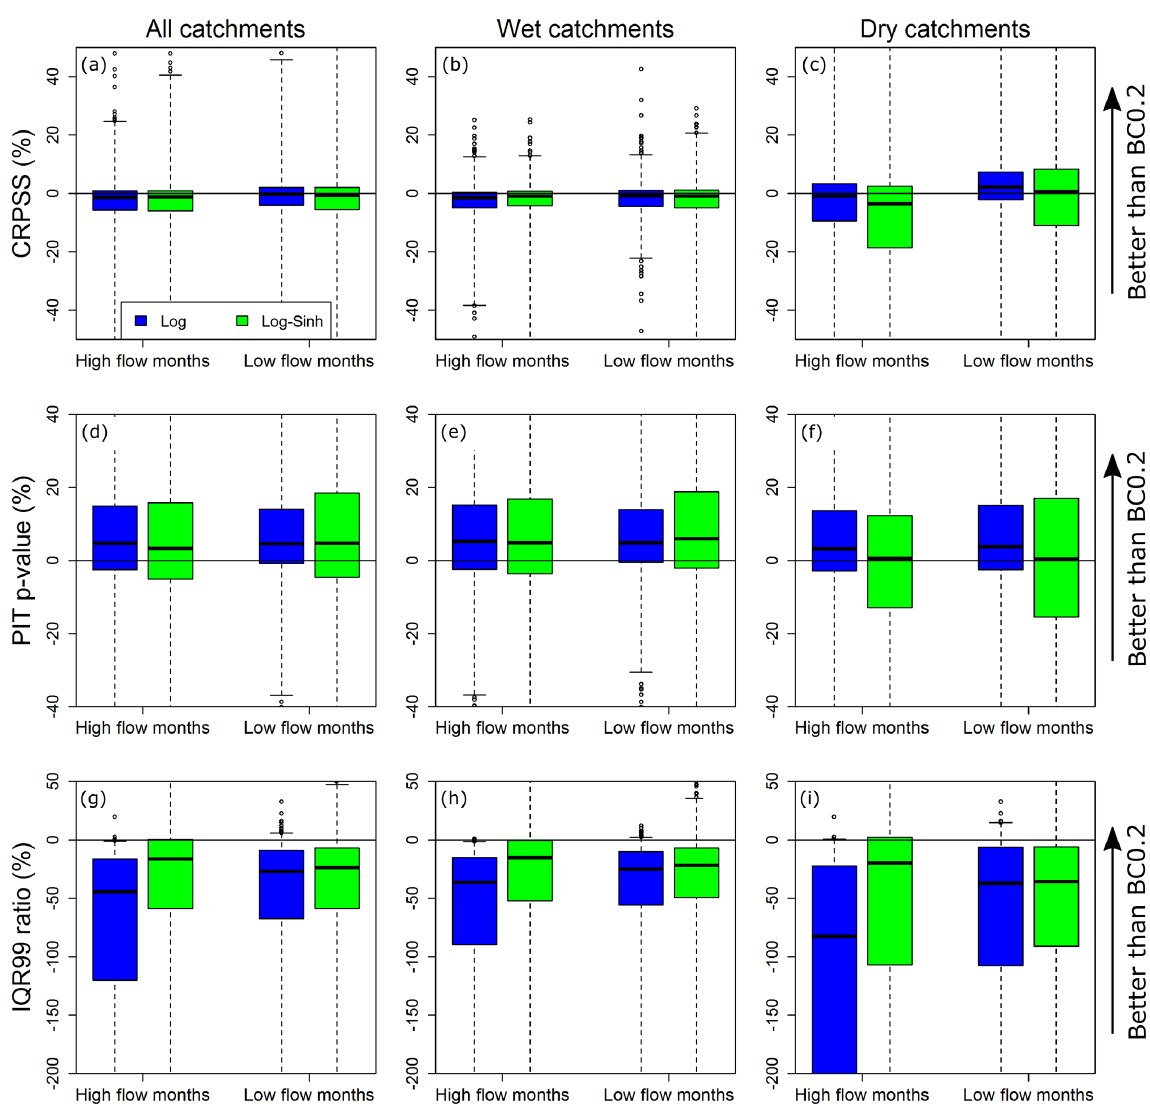
Figure 7. Distributions of differences in the seasonal forecast performance metrics of the Log and Log-Sinh schemes compared to the BC0.2